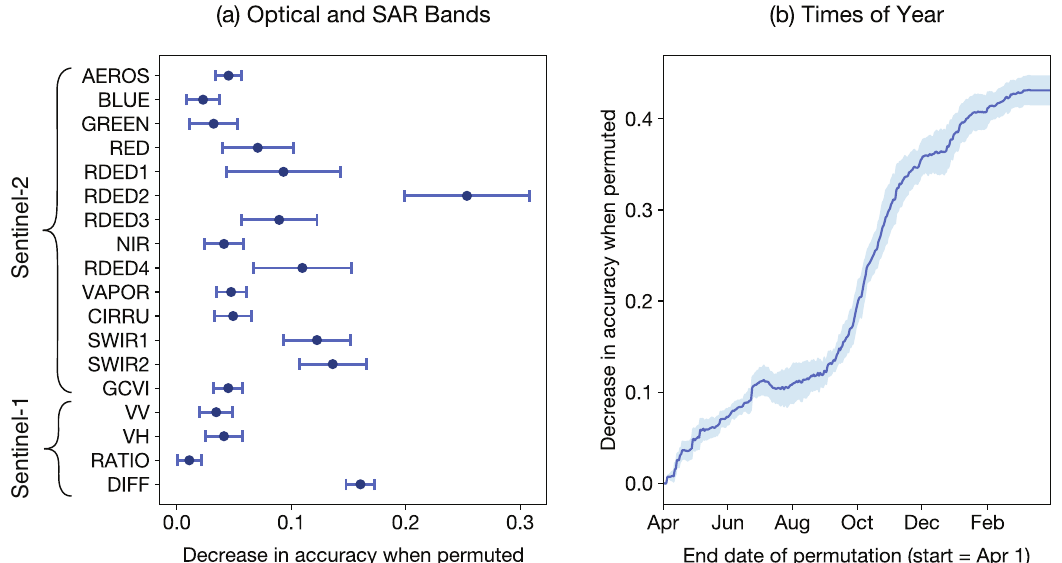
Figure 7. CNN feature importance. Importance was computed as the decrease in validation set accuracy when the feature was permuted across samples, breaking the association between the feature and the label. For the 1D CNN, permuted features were ( a ) optical and SAR bands and ( b ) times of year. Error bars were obtained over 10 runs with 10 different bootstrapped training